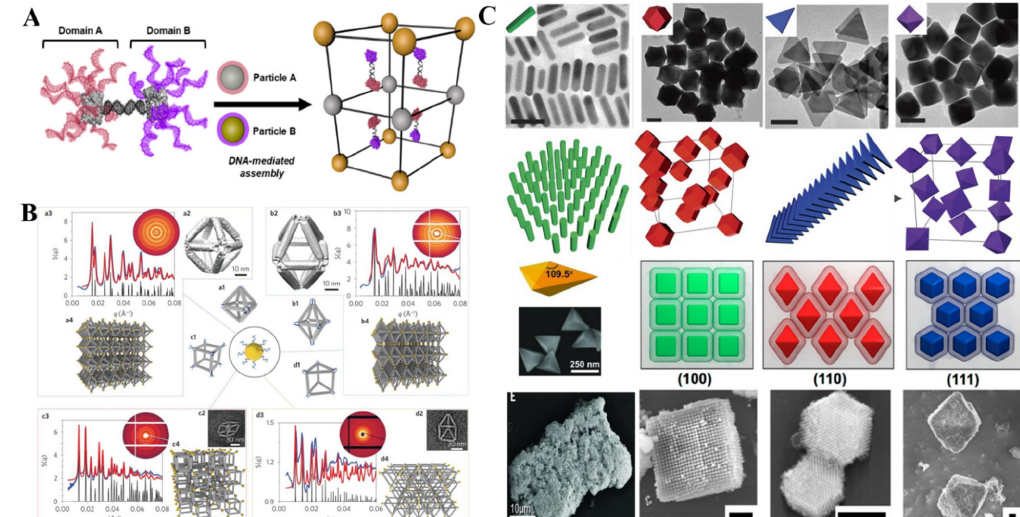
Figure 1. Strategies of control the valency and directional binding of PAE core by patchy or asymmetrically functionalized particles strategies ( A ) (Adapted with permission from [11]. Copyright 2018, American Chemical Society), anisotropic DNA origami framework ( B ) (Adapted with permission from [13]. Copyright 2012, Springer Nature.), and isotropic functionalization on the surface of non-spherical NPs ( C ) (Adapted with permission from [15]. Copyright 2016, American Chemical Society.) (Adapted with permission from [18]. Copyright 2017, Springer Nature.) NPs core with different shapes (top) and the corresponding lattice (bottom).